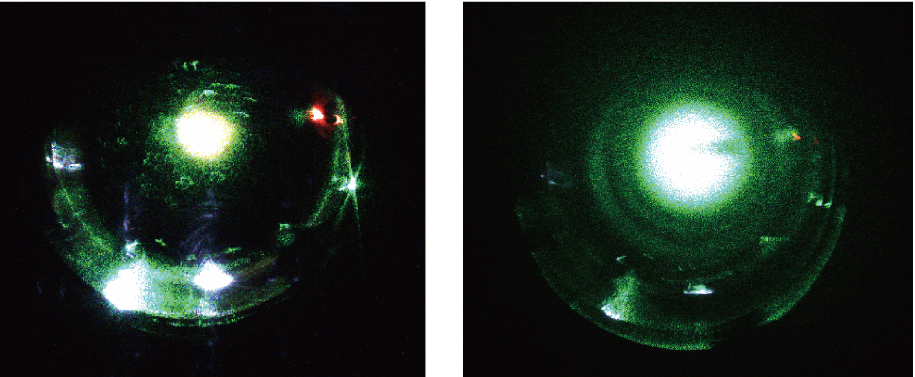
Figure 9. Images of the mirror illuminated with a green laser. ( Left ) Image at room temperature. The mirror surface is clean, and the green beam scattering is smaller than that at cryogenic temperature. ( Right ) Image at cryogenic temperature. The mirror surface is covered with thick frost, and the green beam is scattered on the